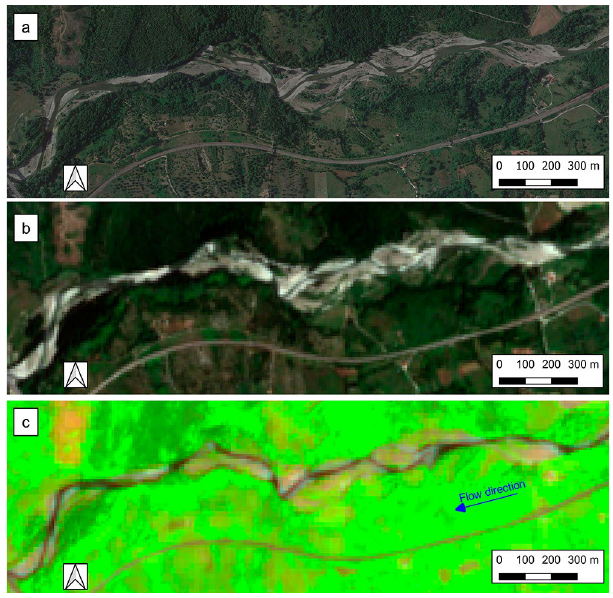
Figure 3. Test case n°1, M1 reach, ( a ) Maps Data: Google, © 14 June 2019, ( b ) RGB extracted by Sentinel-2 acquisition of 12 June 2019 and ( c ) FCI extracted by Sentinel-2 acquisition of 12 June 2019. QGIS 3.10.11 https:// www. qgis. org/ it/ site/ forus ers/ downl oad. html.